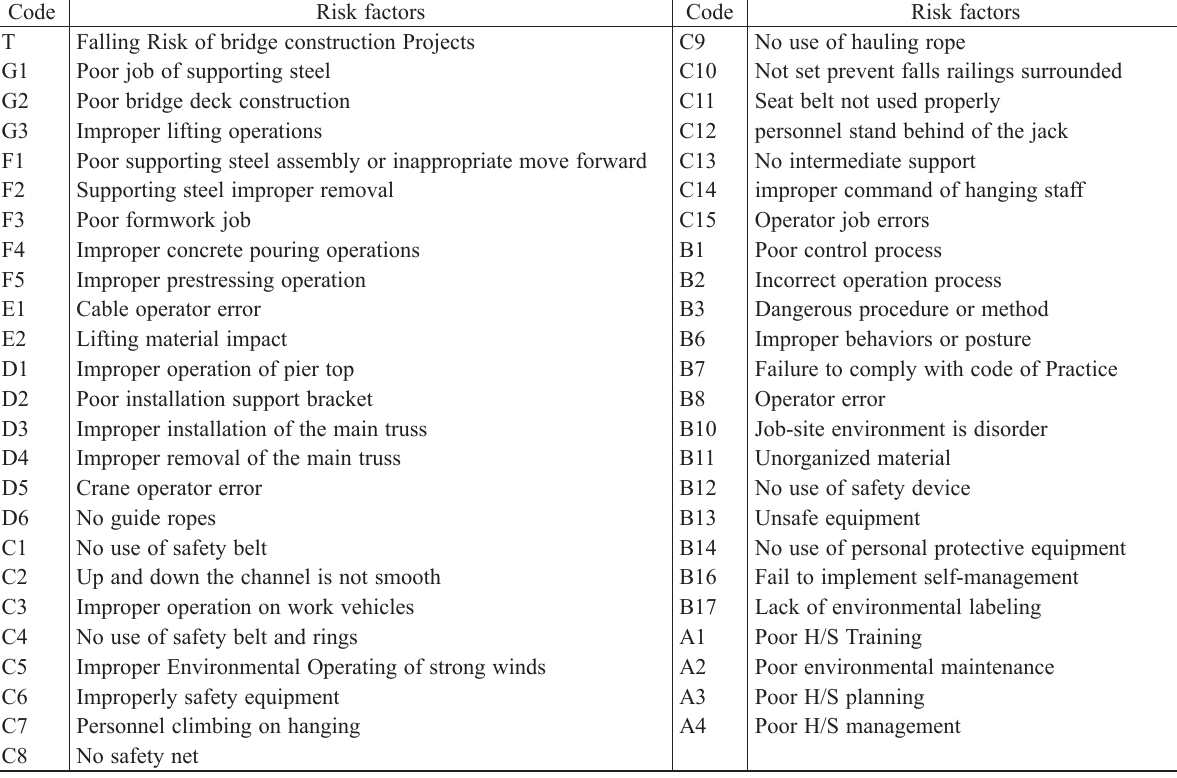
Table 2. Codes and definition of overall FT of falling accidents